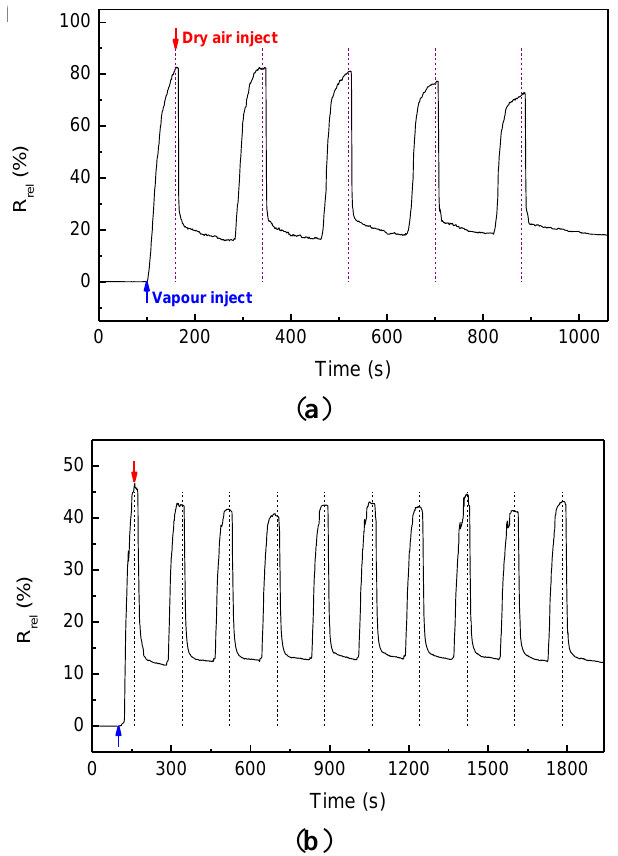
Figure 4. ( a ) Typical resistance response (R rel ) of MWCNT-coated cellulose fiber to ethanol diluted vapor (7%) for five cycles; ( b ) the resistance response (R rel ) of MWCNT-coated cellulose fibers to diluted acetone vapor (30%) for ten